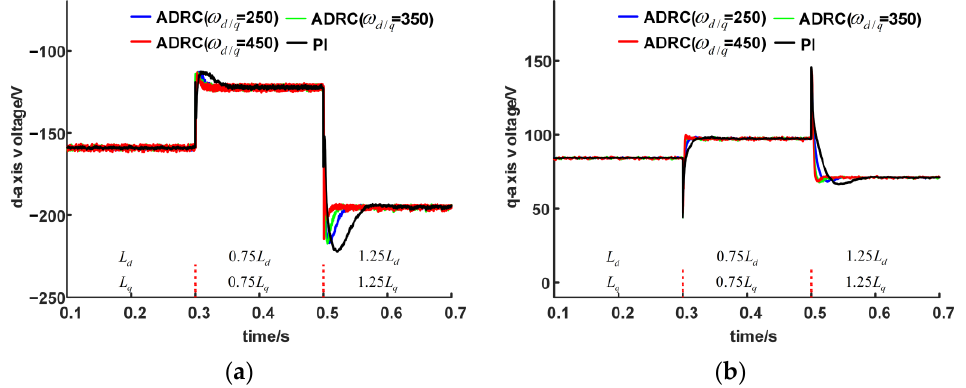
Figure 5. Dq-axis voltage waveforms: ( a ) d-axis voltage; ( b ) q-axis voltage.